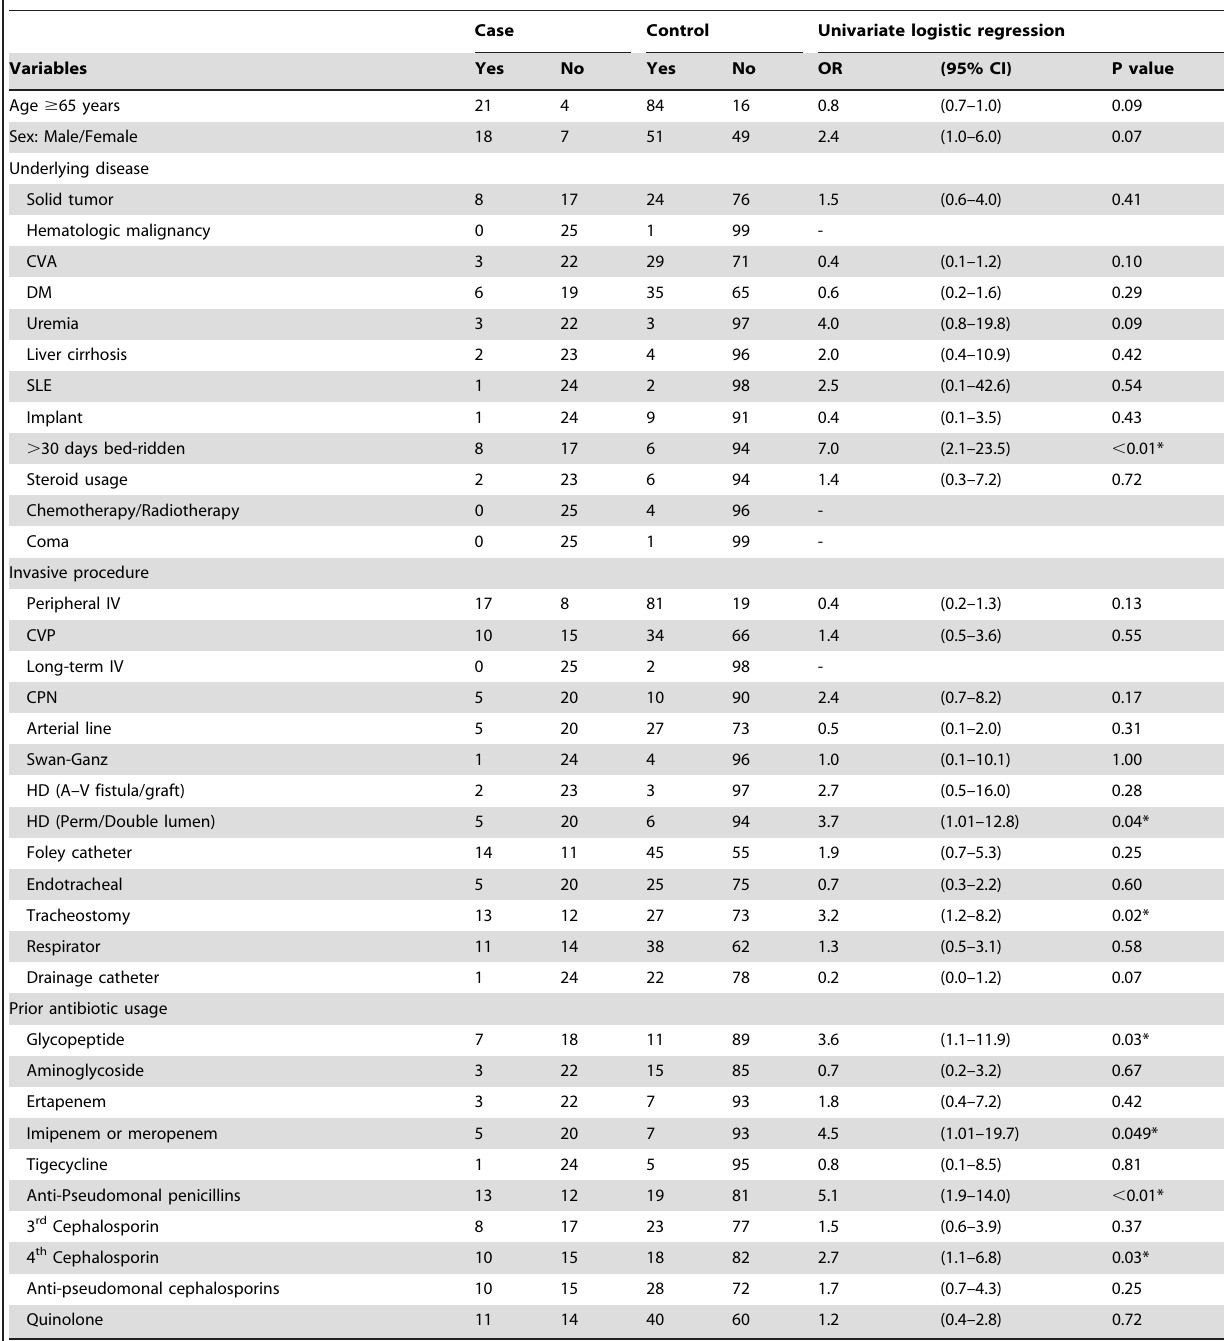
Table 2. Risk factors for XDRAB-HAIs: univariate